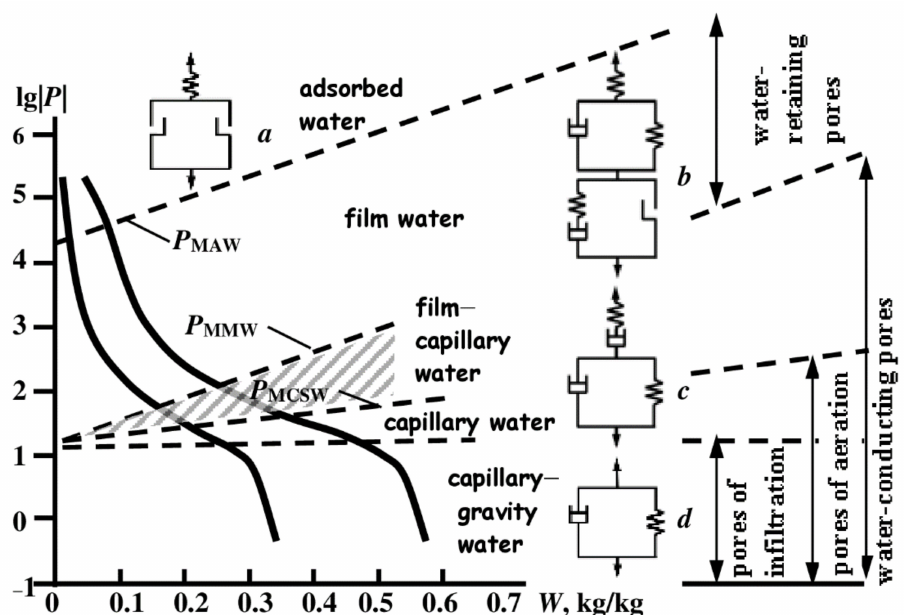
Figure 1. WRC as a physical soil passport (according to (Voronin [7]). Dashed lines are the Voronin empirical secants with the following equations: lg| P MAW | = 4.2 + 3 W ; lg| P MMW | = 1.17 + 3 W ; lg| P MCSW | = 1.17 + W . Rheological models and soil consistency: a -fragile state, the Hook and Saint- Venant model; b -elastic-fragile and fragile-elastic state, the complex Goldstein model; c -viscoelastic state, the Burges and Kelvin model; d -viscous-flow state, the Voigt and Kelvin model. The shaded area has optimal conditions for soil tillage and saving of irrigation